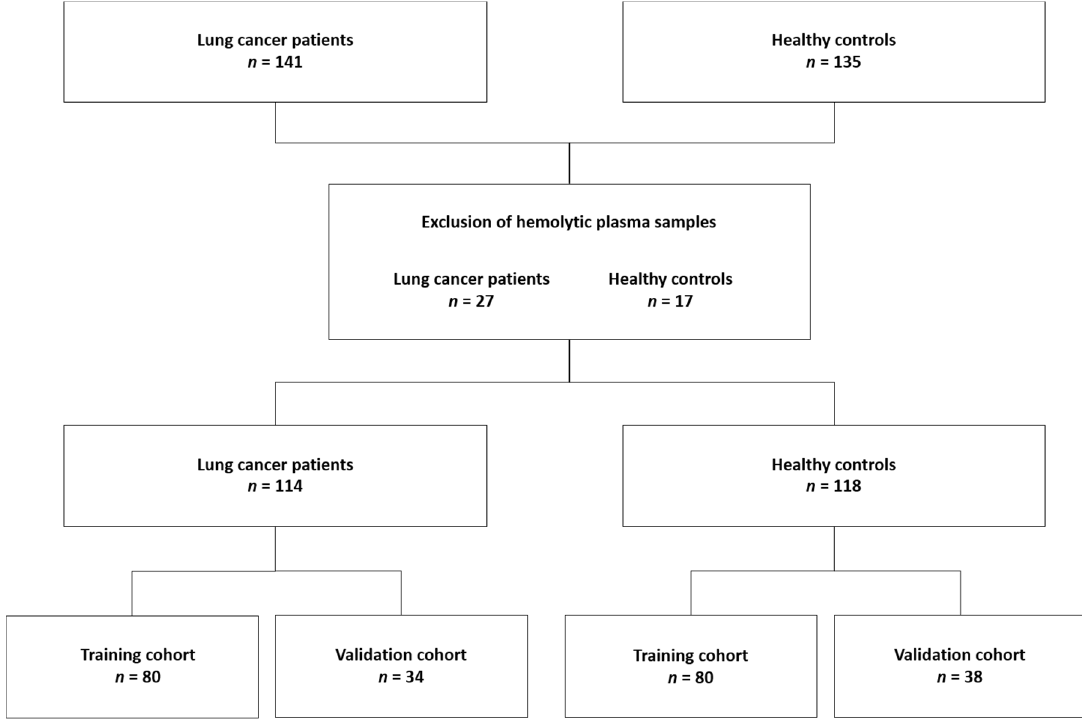
Figure 5. CONSORT diagram of the subjects enrolled in the training ( n = 160) and validation ( n = 72) cohort.